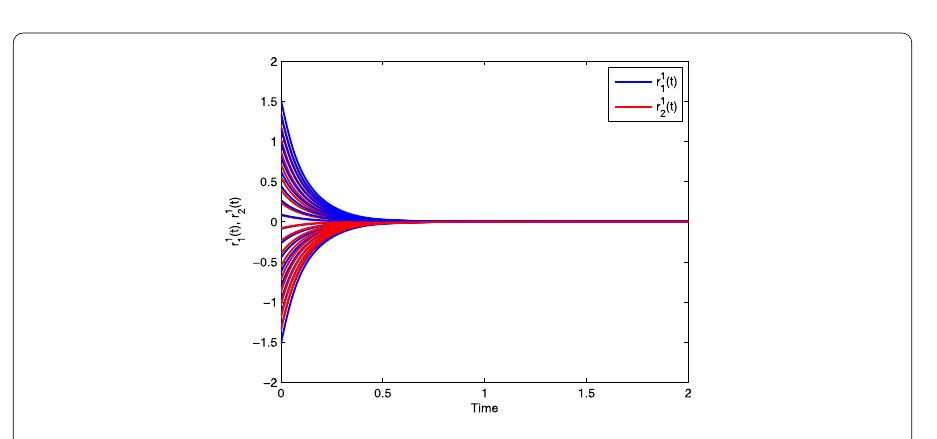
Figure 2 The time responses of states r 1 1 ( t ), r 1 2 ( t ) of NN model (36)